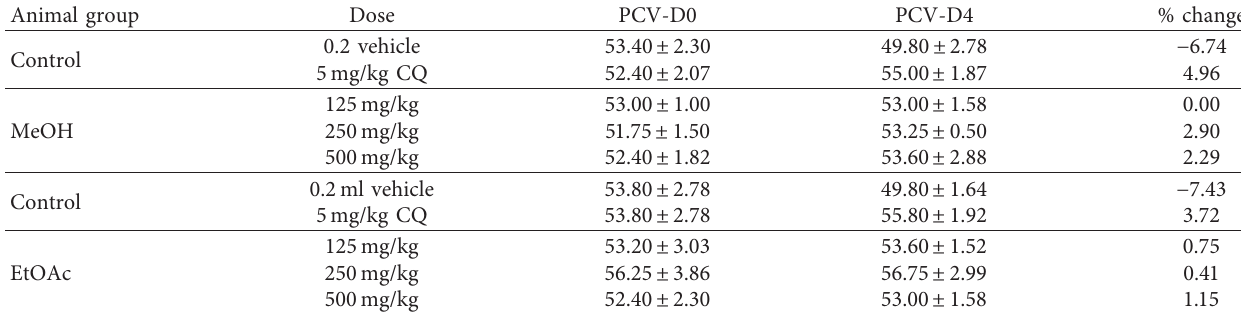
Table 5: Packed cell volume on D0 and D4.